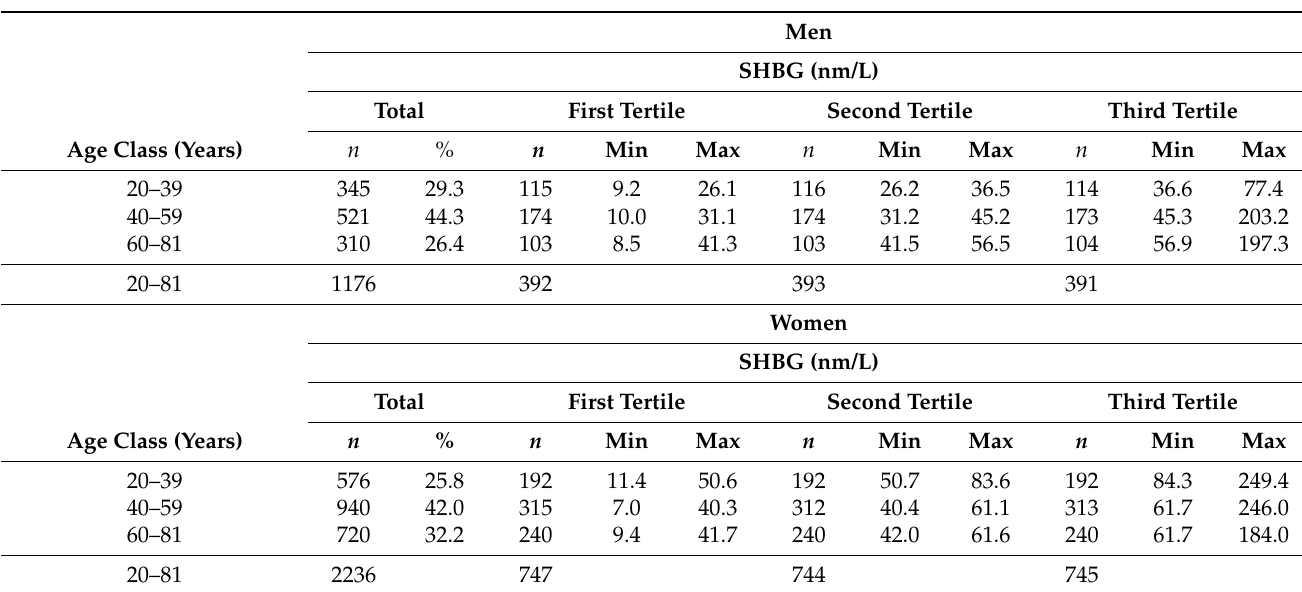
Table 2. Sex Hormone-Binding Globulin (SHBG) tertiles by age groups and sex. The Malattie Ateroscle- rotiche Istituto Superiore di Sanit à (MATISS) study, men and women aged 20–81 years